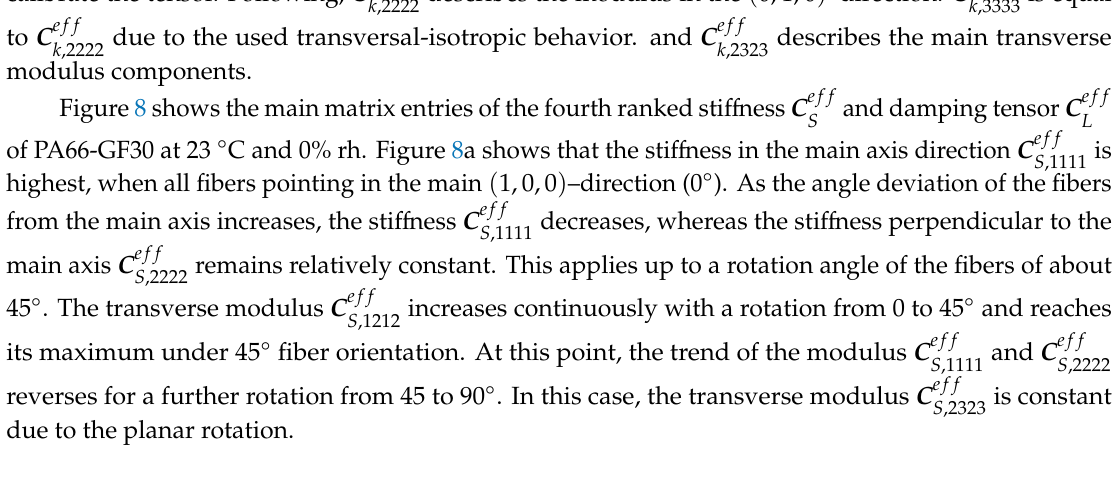
Figure 7. Schematic explanation of the rotating procedure of the unidirectional, transversal-isotropic tensors in different fiber directions.